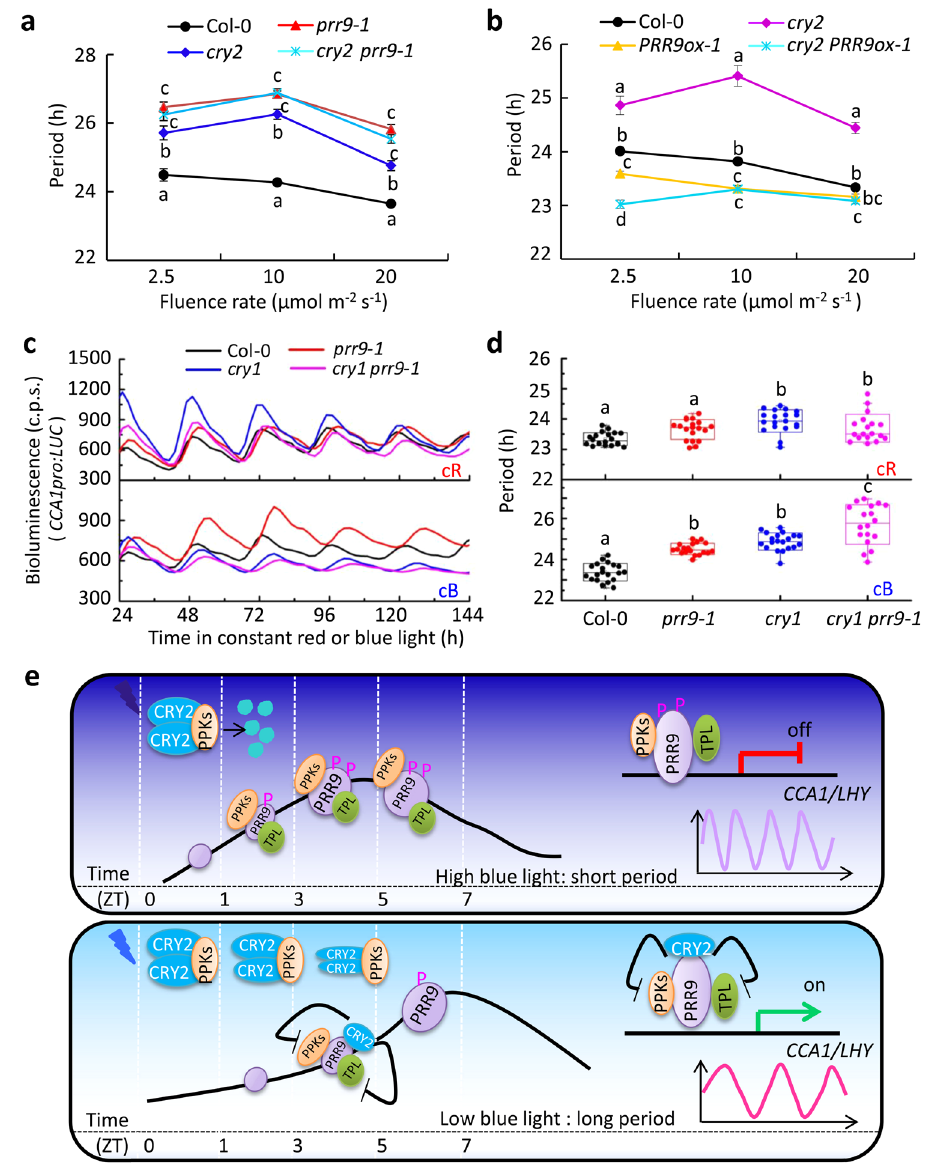
Fig. 7 | PRR9 genetically acts downstream of CRY2 in regulating the circadian period. a , b Fluence response curve showing free-running period length of CCA1- pro:LUC in Col-0, prr9-1 , cry2 , and cry2 prr9-1 plants ( a ) (2.5 μ molm − 2 s − 1 : n =19, 16, 16, 18; 10 μ molm − 2 s − 1 : n =17, 19, 18, 19; 20 μ molm − 2 s − 1 : n =20, 19, 20,19, respec- tively)orCol-0, cry2 , PRR9ox-1 ,and cry2PRR9ox-1 plants(2.5 μ molm − 2 s − 1 : n =17,17, 17,15;10 μ molm − 2 s − 1 : n =17,17,18,15;20 μ molm − 2 s − 1 : n =18,18,18,19,respectively) under constant blue light at sequential fl uent rates. Data represent mean±s.e.m. Lowercase lettersin a and b indicate signi fi cant differences, different genotypesat each light intensity were respectively analyzed through one-way ANOVA followed by the Fisher ’ s LSD test. c , d Bioluminescence traces of CCA1pro:LUC ( c ) and the estimated free-running period ( d ) for Col-0, prr9-1 , cry1 , and cry1 prr9-1 seedlings undercontinuousred( n =20,19,19,18,respectively)orbluelight( n =20,19,20,18, respectively) (40 μ molm − 2 s − 1 ) condition. Data were mean±s.d., and